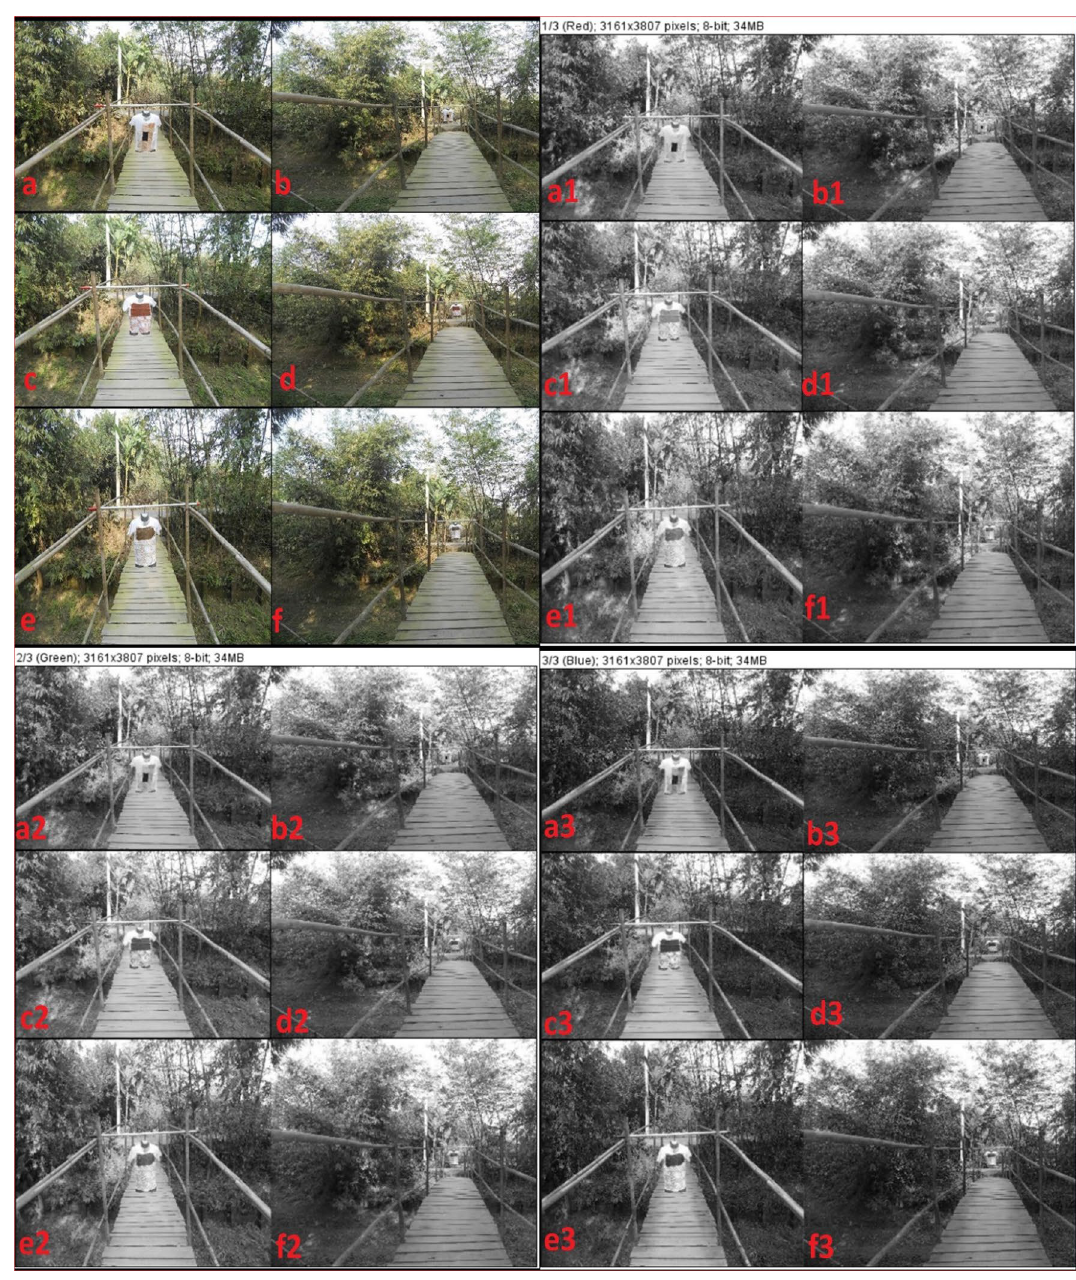
Figure 11. NPND-dyed-coated-printed garments placed against woodland CB and wooden bridge; and shown the photometric versus colorimetric views of red ( a1 – f1 ), green ( a2 – f2 ), blue ( a3 – f3 ) in grey scale imaging of RGB raw image ( a – f ) when the pictorial mapping has been engendered as a1 = a2 = a3 = a4; b1 = b2 = b3 = b4; c1 = c2 = c3 = c4; d1 = d2 = d3 = d4; e1 = e2 = e3 = e4; f1 = f2 = f3 = f4 for chromatic